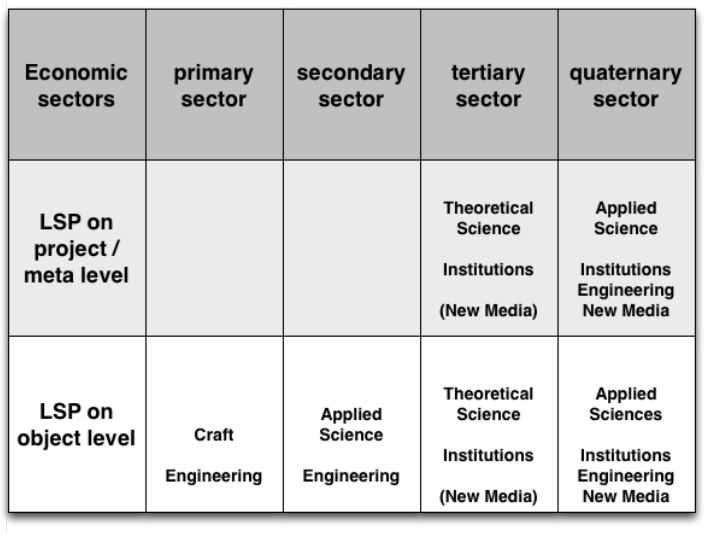
Fig.4: horizontal structuring based on economic sectors as applied to communication within a research project